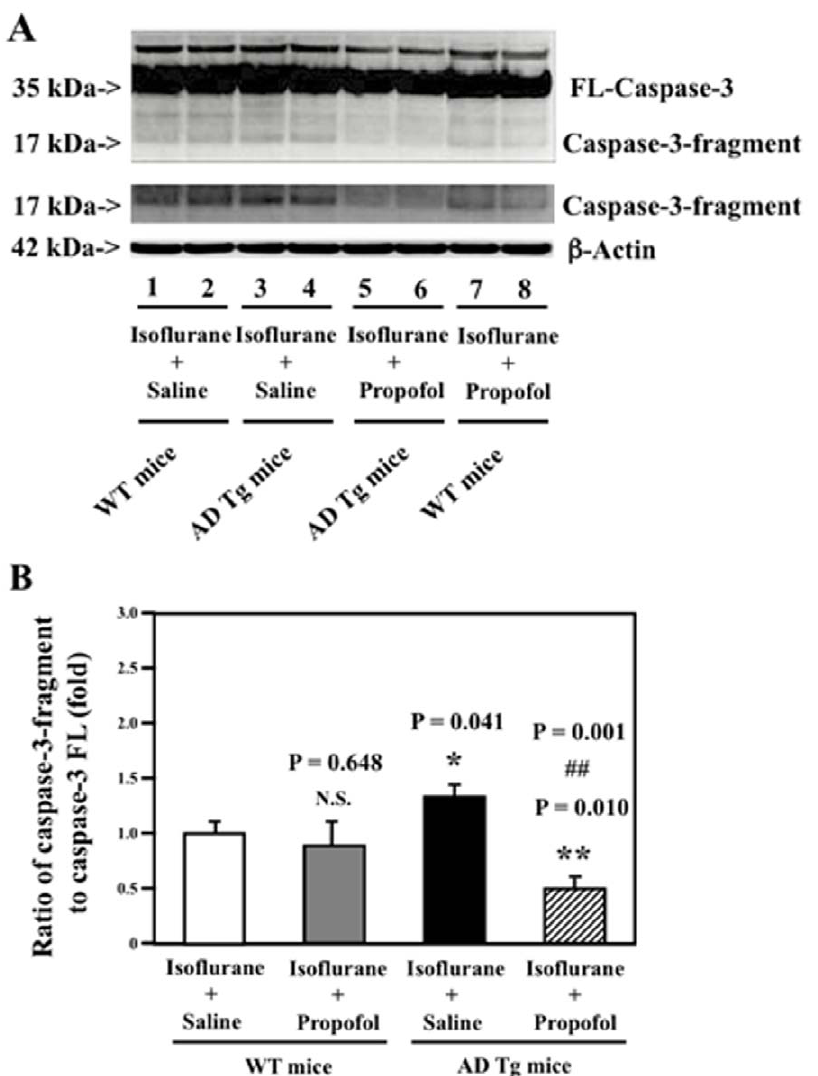
Figure 3. Propofol attenuates the isoflurane-induced caspase-3 activation in AD Tg neonatal mice but not in WT neonatal mice. A. In WT neonatal mice, the propofol treatment (lanes 7 and 8) does not attenuate the isoflurane-induced caspase-3 activation (lanes 1 and 2). Isoflurane induces a greater degree of caspase-3 activation in the AD Tg neonatal mice (lanes 3 and 4) as compared to that in WT neonatal mice (lanes 1 and 2). The propofol treatment (lanes 5 and 6) attenuates the isoflurane-induced caspase-3 activation (lanes 3 and 4) in the AD Tg neonatal mice. B. Quantification of the Western blot shows that propofol (grey bar) does not attenuate the isoflurane-induced caspase-3 activation (white bar) in the WT neonatal mice. Isoflurane induces a greater degree of caspase-3 activation in the AD Tg neonatal mice (black bar, * P=0.041) than in the WT neonatal mice (white bar). In the AD Tg neonatal mice, propofol (net bar, ## P=0.001) attenuates the isoflurane-induced caspase-3 activation (black bar).